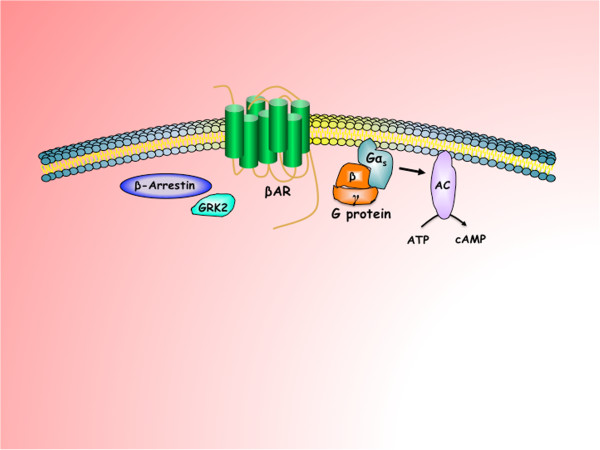
Classical pathway of β2adrenergic receptor (β2AR) activating Gαsprotein, which in turn activates the conversion of ATP in cAMP by the adenylate cyclase (AC). An alternative signaling pathway involves Gαi protein. G-protein-linked receptor kinase 2 (GRK2) and β-Arrestin participate in the desensitization process of the receptor.